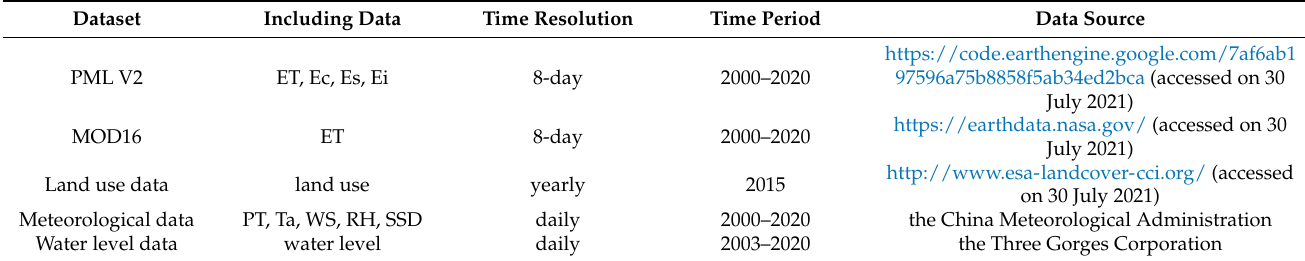
Table 1. Detailed information of datasets used in this study.